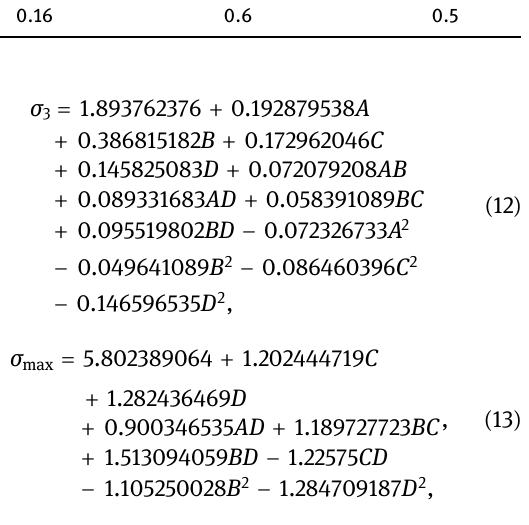
Table 3: Values of basic parameters Parameter Type